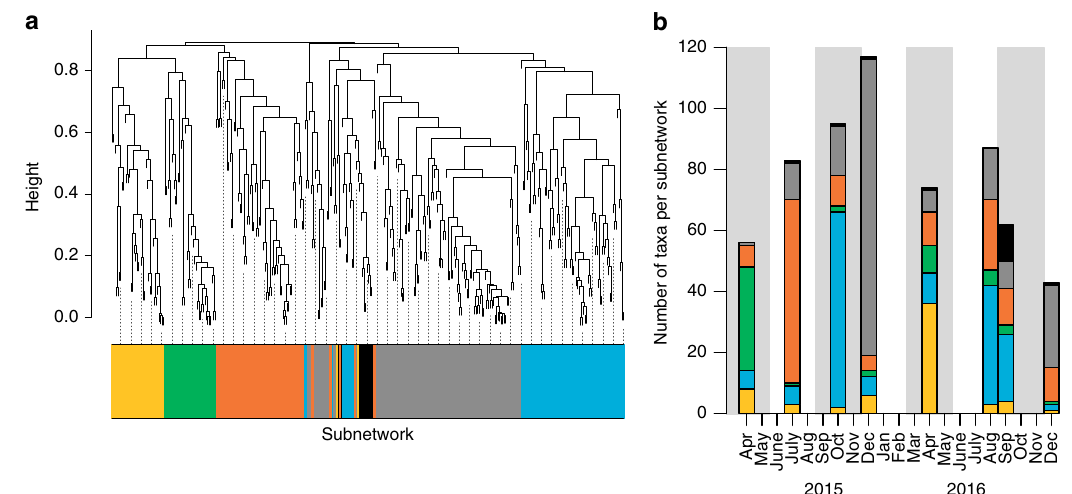
Fig. 1 Weighted gene correlation network analysis (WGCNA) of eDNA data correlated with environmental variables. a Dendrogram based on clustering of changes in abundance indices of all taxa using Kendall ’ s tau correlation coef fi cient (see Methods). The colours correspond to different subnetworks. b Observed richness of taxa from each subnetwork, from Fig. 1a, over the sampling time points showing the highest accumulative richness in December 2015. The shaded areas represent the spring and autumn seasons and white represents the summer and winter